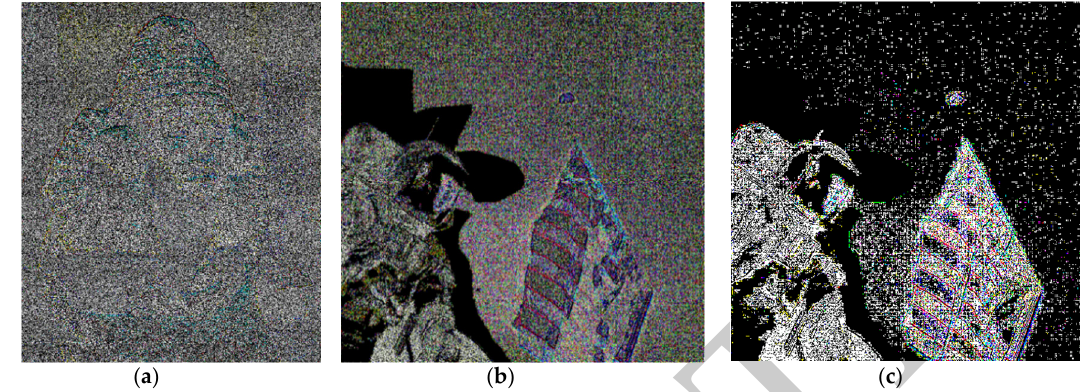
Figure 3. Examination and comparison of the noise of a real photo with photo GPN-2000-00113 clearly shows that GPN- 2000-00113 is composed of two parts separated by a black background with no noise on it. ( a ) Random uniform noise on an actual photo; ( b ) Wikipedia-commons photo (1998); ( c ) Internet Archive photo (1972).